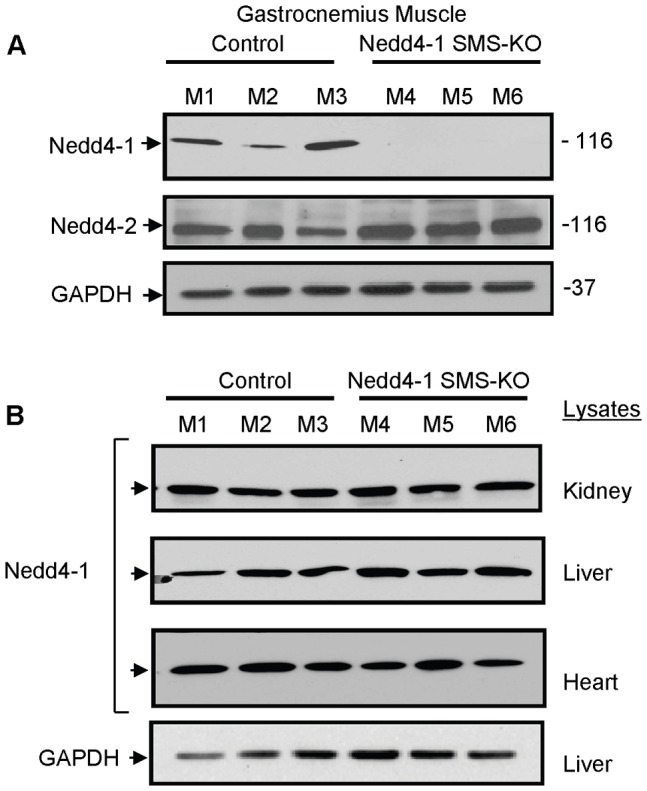
Nedd4-1 protein is absent from MyoCre;Nedd4-1flox/flox (Nedd4-1 SMS-KO) skeletal muscle.(A) SDS-PAGE and Nedd4-1 Western blotting (WB) of 50 µg of gastrocnemius muscle lysates from representative Nedd4-1 SMS-KO mice (M4, M5, M6) and littermate MyoCre;Nedd4-1+/+ control mice (M1, M2, M3) reveal the absence of Nedd4-1 in the Nedd4-1 SMS-KO muscle. Nedd4-2 protein remains equally expressed in the muscle of Nedd4-1 SMS-KO and MyoCre;Nedd4-1+/+ control mice. GAPDH served as a loading control. (B) WB of heart, liver and kidney protein lysates reveal equal Nedd4-1 protein in these tissues in the Nedd4-1 SMS-KO and littermate MyoCre;Nedd4-1+/+ control mice. GAPDH served as a loading control for all blots; liver lysate is shown as a representative blot.